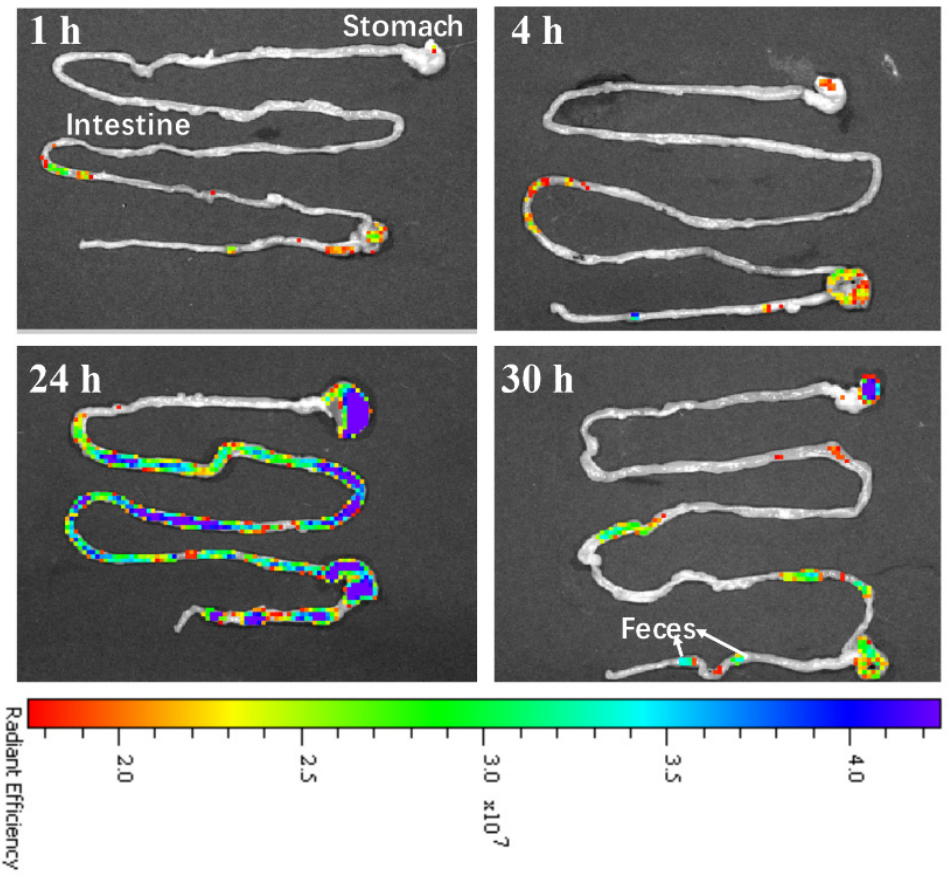
Figure 7. Fluorescent images of the ex vivo stomach and intestine from mice injected with CDs@PEI nanoparticles at 1, 4, 24, and 30 h.